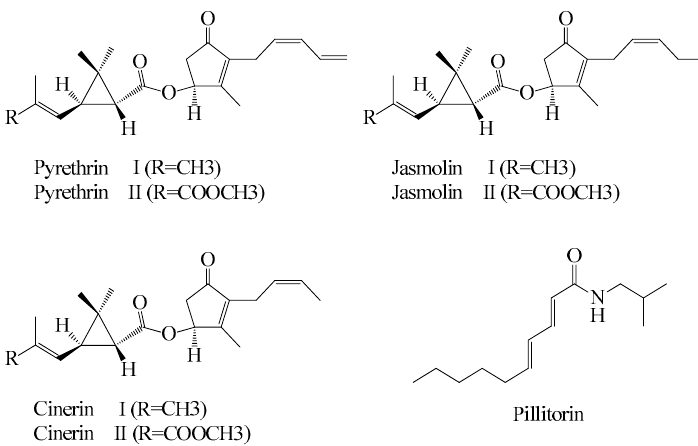
Figure 3. Chemical structures of the non-volatile components isolated from Anacyclus pyrethrum.